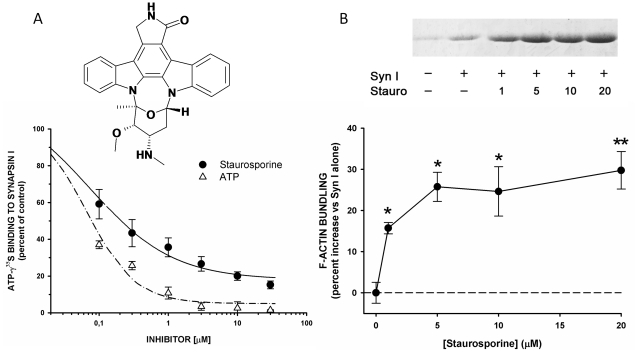
Staurosporine binds to synapsin I and affects synapsin I-dependent F-actin bundling.A. Upper panel: Chemical structure of staurosporine. Lower panel : Inhibition of ATP-γ35S (0.2 µM) binding to purified bovine synapsin I (0.5 µM) by increasing concentrations of either cold ATP (open triangles) or staurosporine (filled circle). The amount of ATP-γ35S bound in the presence of the inhibitors is expressed in percent of the binding under control conditions (absence of either inhibitor). Points in the plot are means ± sem from 5 independent experiments. Inhibition curves were fitted using a 3-parameter sygmoidal dose-response function yielding IC50 and lower plateau values (see Fig. 6). B. The F-actin bundling activity of synapsin I (final concentrations : synapsin I, 0.5 µM; F-actin, 5 µM) in the absence or presence of the indicated concentration of staurosporine (1–20 µM) was evaluated by using the low speed sedimentation assay. The actin recovery in the pellet was evaluated by densitometric analysis of the actin bands from Coomassie-stained gels of the solubilized pellets. A representative experiment is shown in the upper panel (staurosporine concentrations are shown in µM). The percent increases in actin bundling observed in the presence of increasing concentrations of staurosporine, with respect to the samples containing F-actin and synapsin I only, is shown in the lower panel as means ± sem from 5 independent experiments. Statistical analysis was carried out by one-way Anova followed by the post-hoc Dunnett's multiple comparison test (*, p<0.05 ; **, p<0.01).